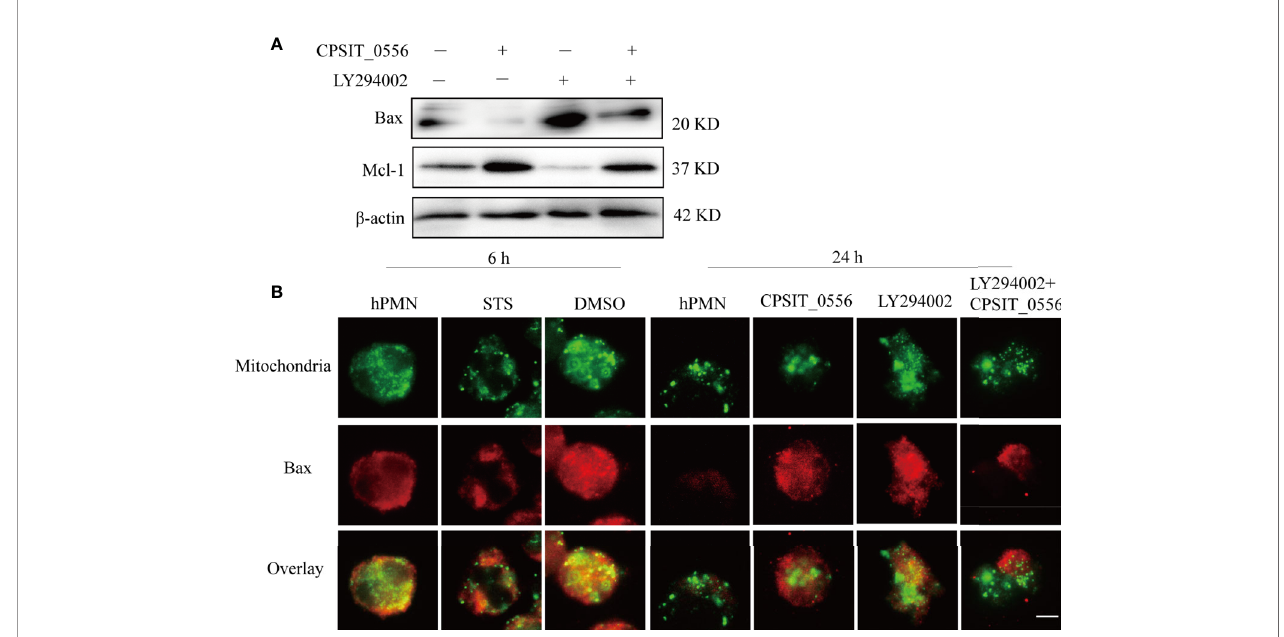
FIGURE 5 | Activation of the PI3K/Akt pathway inhibits Bax from entering the mitochondrial membrane. (A) HPMN were pre-treated with the PI3K inhibitor LY294002 (25 m M) for 30 min and then cultured with 20 m g/mL CPSIT_0556 for 6 h. Western blotting showing the expression levels of Bax and Mcl-1. (B) HPMN were left untreated, treated with DMSO or STS as indicated for 6 h, or treated with CPSIT_0556, 25 m M LY294002, LY294002 was co-incubated with CPSIT_0556 for 24 h, stained with rabbit anti-SOD2 monoclonal (1:50 dilution) and mouse anti-Bax monoclonal (1:50 dilution), then incubated with Cy3-conjugated goat anti- mouse IgG (1:200 dilution) and Cy2-conjugated goat anti-rabbit IgG (1:200 dilution). DAPI staining of the nucleus, the cytoplasmic distribution of mitochondria (green fl uorescence), and Bax (red fl uorescence) were detected by double immuno fl uorescence labeling. Imaging results were observed by an optical microscope (×1000, in oil). The scale bar is 5 µm, the image represents at least three separate